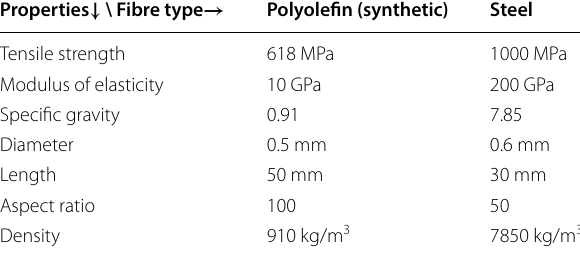
Table 2 Properties of